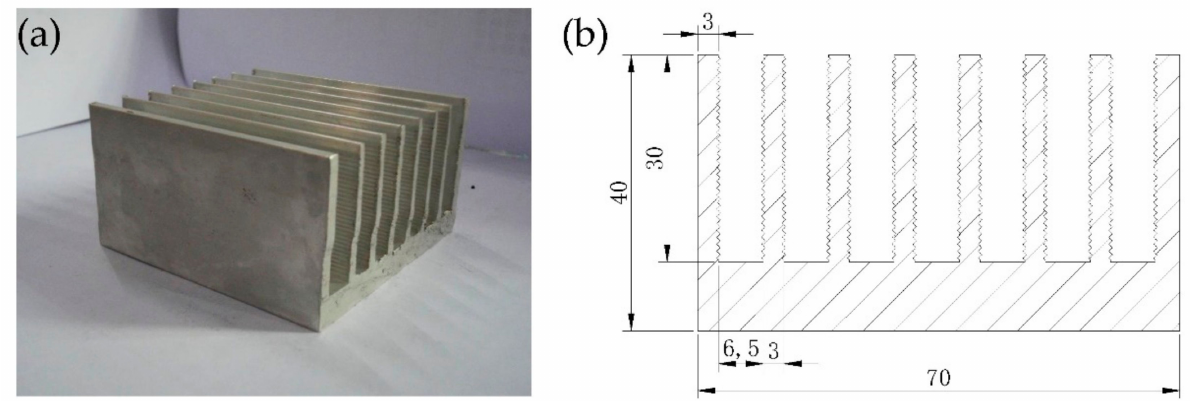
Figure 1. Heat sink sample used for surface treatment: ( a ) photo of the untreated heat sink; ( b ) structural parameters of the heat sink (unit: